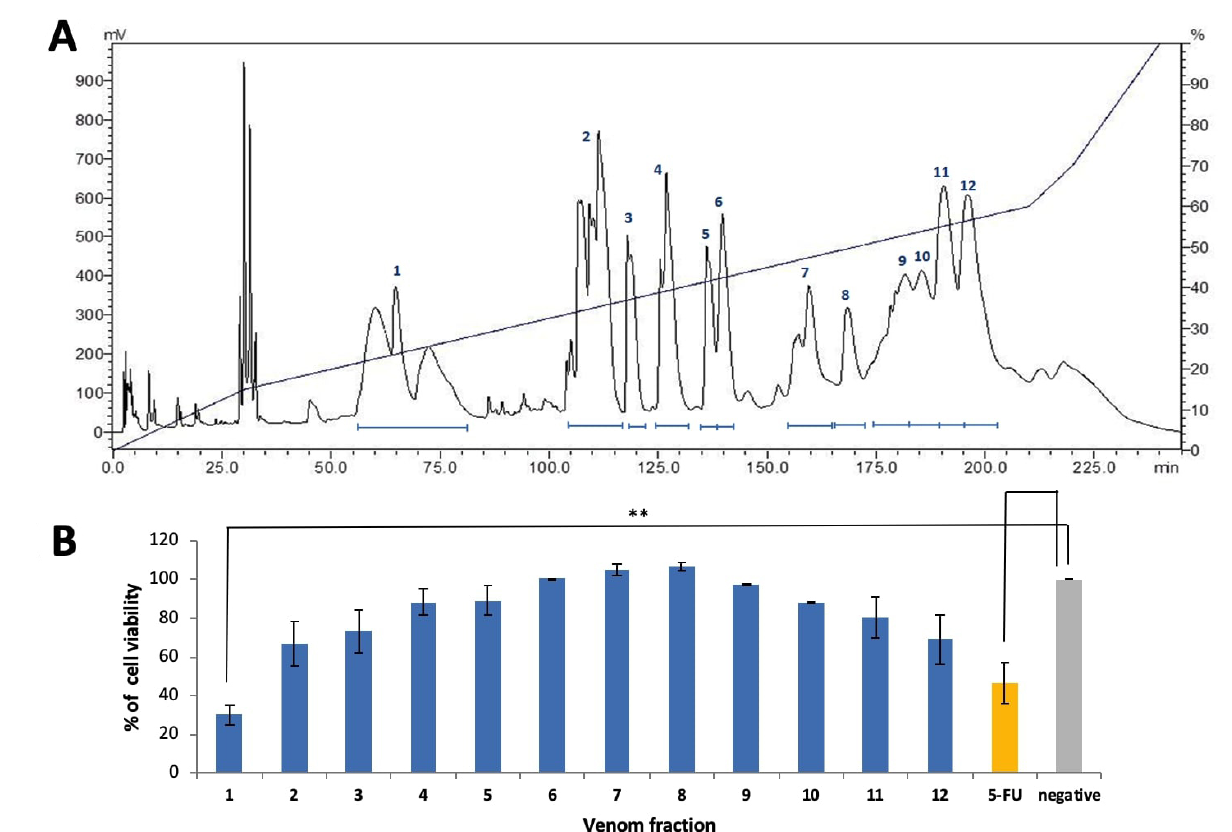
reversed-phase high performance liquid chromatography of venom from the Malaysian T. purpureomaculatus . (B) Cell viability of human breast Figure 2. (A) C 18 cancer cells (MCF7) after 72-hour treatment with the HPLC fractions of Malaysian T. purpureomaculatus venom. Positive and negative controls were 5-fluorouracil (5-FU) and treatment-free, respectively, in the